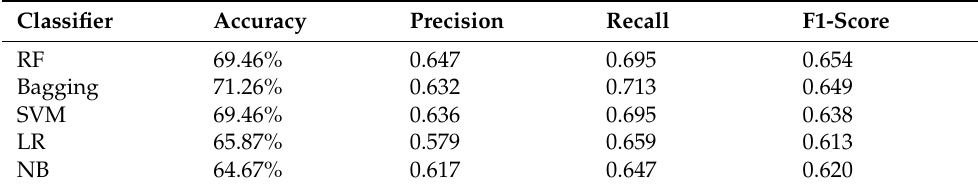
Table 24. Experiments with ML models and all lexicons on the TextBlob sentiments.